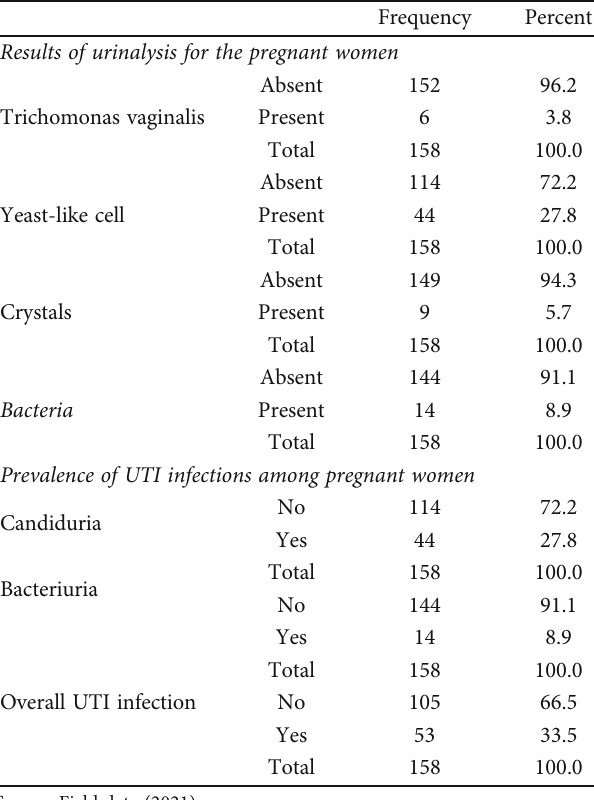
Table 3: Association between maternal age, trimester of pregnancy, and UTI